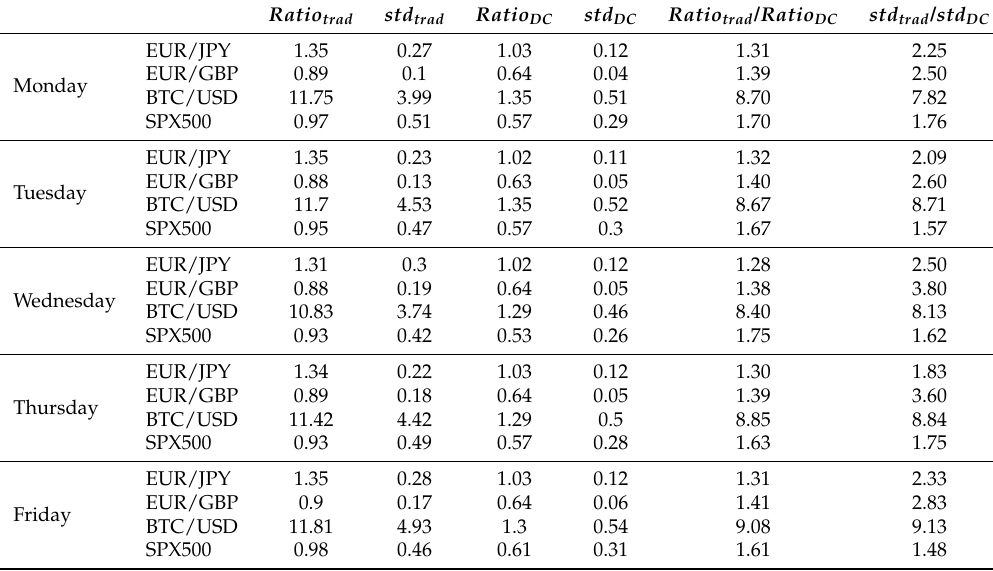
contain the standard ∗